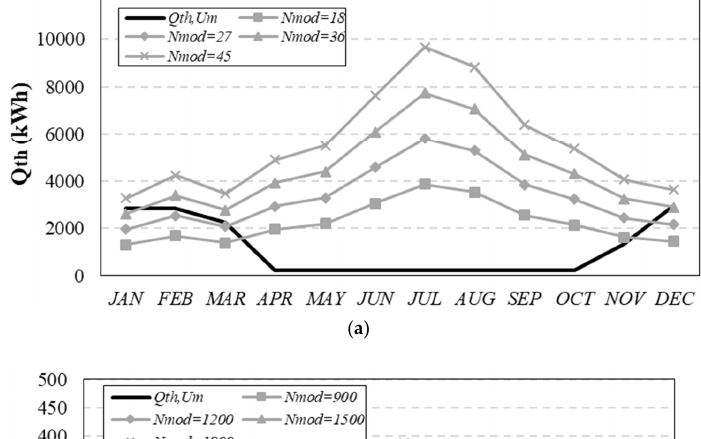
Figure 4. Difference between the CPV/T system electrical outputs on a monthly basis by varying its number of modules and the electrical loads of the three users: ( a ) house; ( b ) hotel; and ( c ) industry. As shown, the domestic user presents a monthly electrical load which is not extremely variable during the year. Hence, in the summer period, the CPV/T system producibility always exceeds the user’s loads for the numbers of modules considered. Thirty-six modules would be sufficient to satisfy the electrical energy needs almost all